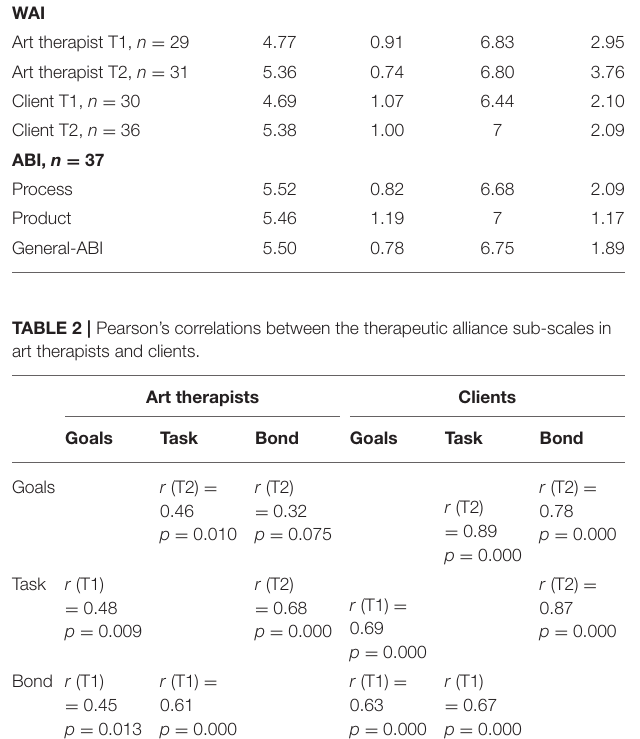
TABLE 1 | Summary of means, standard deviations, and minimum and maximum for scores on WAI and ABI. M SD